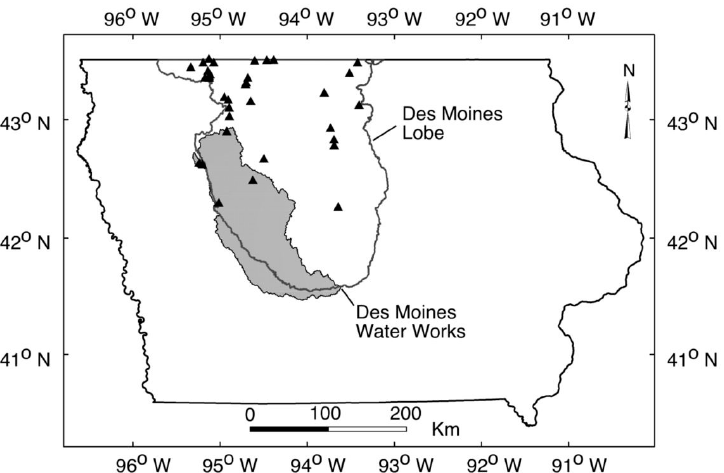
Figure 1. Location of the 33 natural lakes in Iowa discussed in this study (triangles). Most are located within the boundaries of the Des Moines lobe of the Wisconsin Glacier. The shaded area represents the watershed of the Raccoon River above the sampling station at Des Moines, Iowa. Map information is from the Iowa Department of Natural Resources.